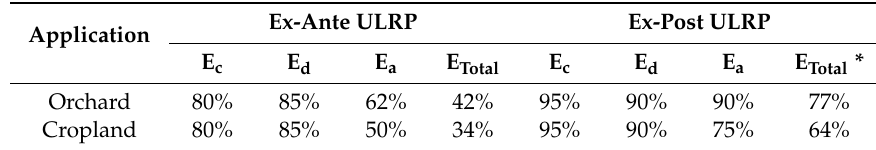
Table 2. The impact of the Urmia Lake Restoration Program (ULRP) Strategy #3 (increasing irrigation e ffi ciency). The irrigation e ffi ciencies were estimated ex-ante (2000–2010) and ex-post (2020–2030) individually for Strategy #3 (3-a to